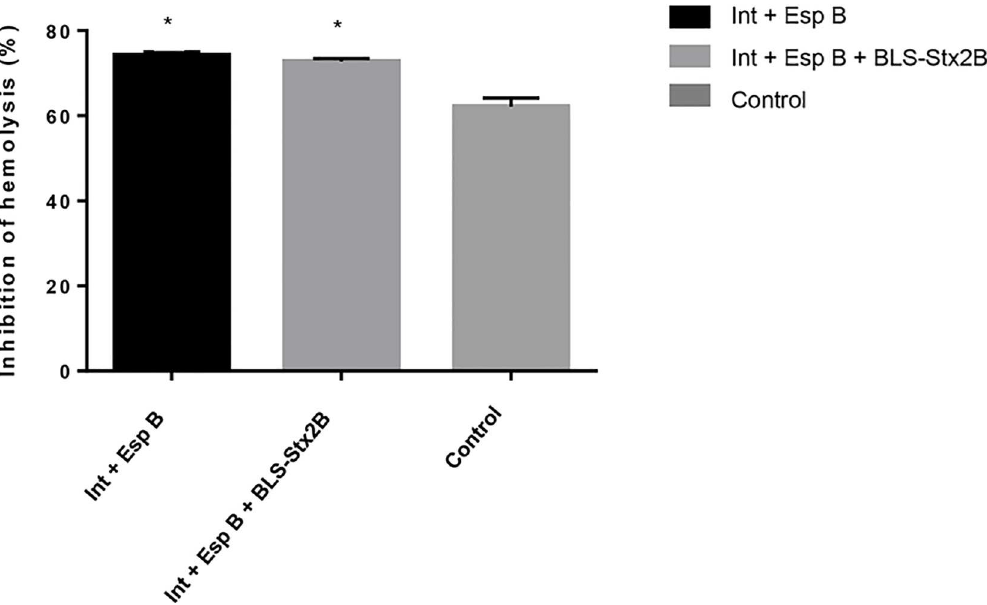
Fig 4. Inhibition of RBC lysis by sera from calvesvaccinated with IntiminC 280 + EspB + BLS-Stx2B (3Ag); IntiminC 280 + EspB (2Ag); and PBS (control). Results are represented as % of inhibitionof RBC lysis caused by the strain EHEC 438/99 without sera. Data are shown as mean ± standarderror of the mean of 3 experiments performed. * Indicates statistical significancecomparedto the control (p <